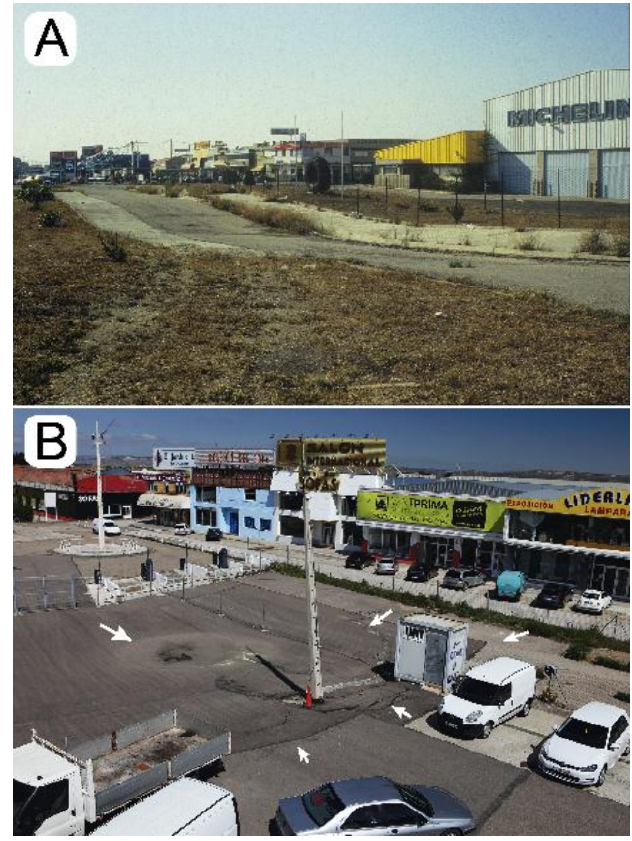
Figure 5. Images of the Logroño highway sinkholes. ( A ) Photograph taken on June 1996 at the NE sector of sinkhole 1 before the enlargement of the highway and the construction of the currently existing department store. Note the conspicuous sagging of the service road and the sidewalk. ( B ) Image of sinkhole 2 taken on April 2016 affecting a recently asphalted surface within a fenced area. The left arrow points to the deeper part of sinkhole and the arrows on the right mark the outermost